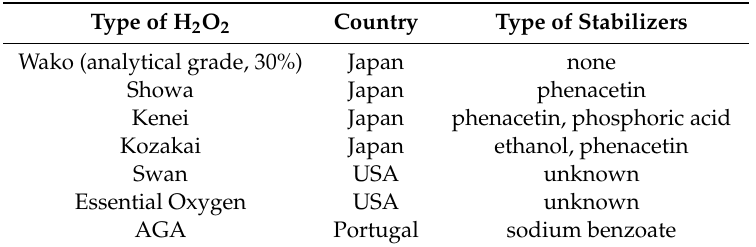
Table 2. Hydrogen peroxide solutions used in this